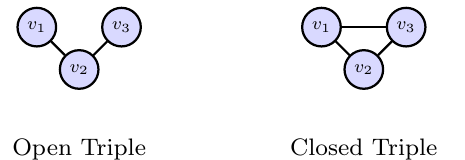
Fig. 1 Open and closed triples used to define the degree of clustering of a graph